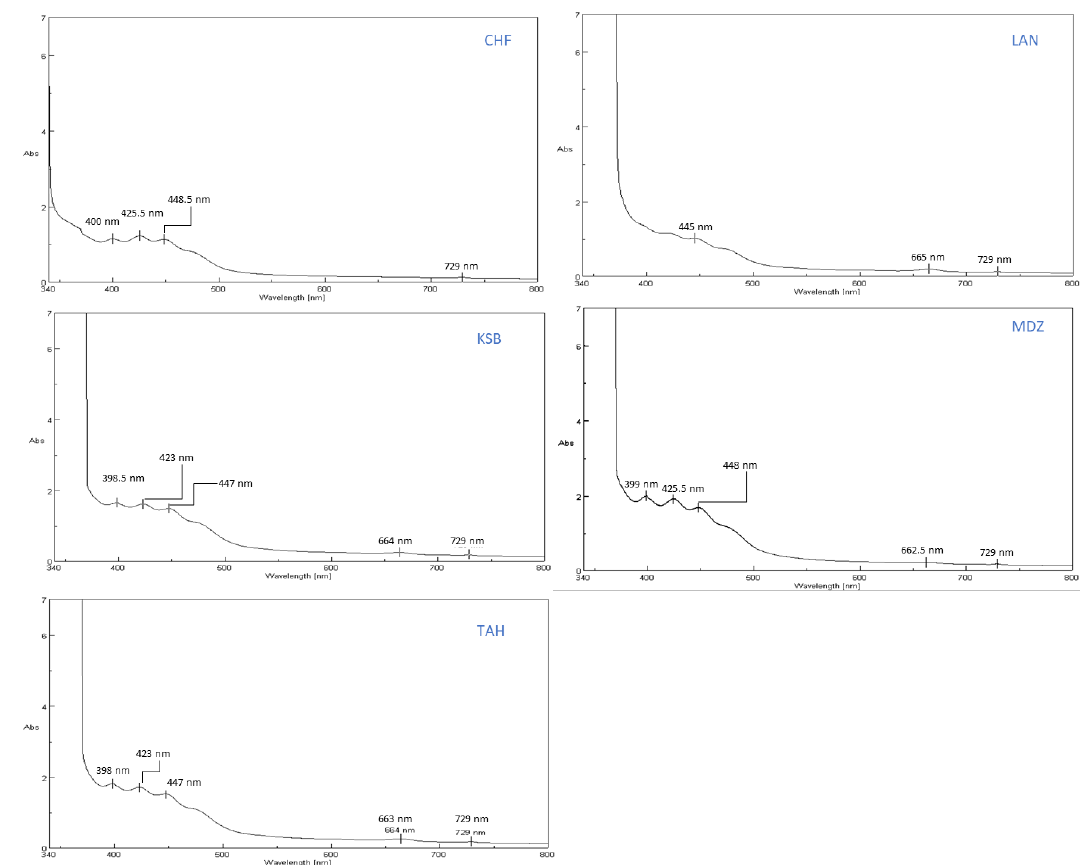
Figure 2. Ultra violet-visible spectroscopy analysis of strawberry tree fruits